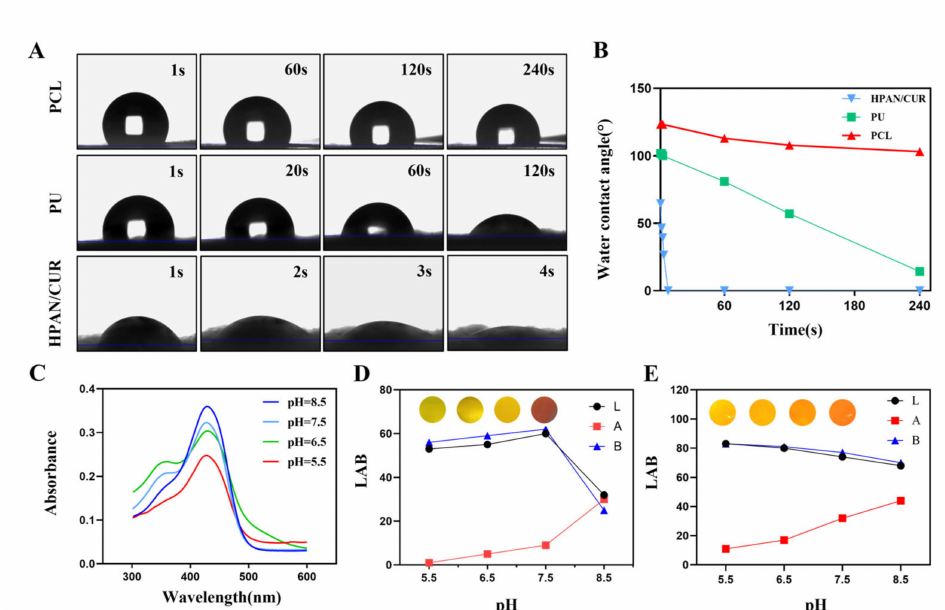
Figure 2. ( A , B ) The photos and values of water contact angle of PCL, PU, HPAN/CUR in different time points. ( C ) Absorbance of 8% curcumin solution at different pH values. ( D ) Color photos and LAB values of 8% curcumin solution at different pH values. ( E ) Color photos and LAB values of trilayer dressing at different pH values. (LAB: The values of the three channels L, A, and B represent the color of the